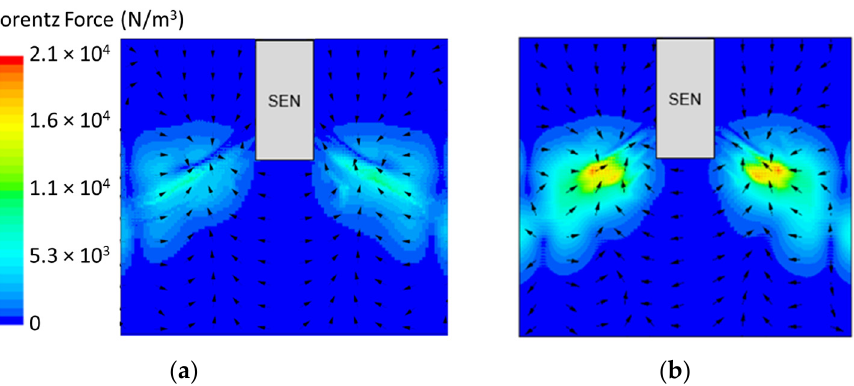
Figure 8. ( a ) Low EMBr strength 2975 G (Case 2) vs. ( b ) high EMBr strength 4350 G (Case 1) Lorentz force distribution.